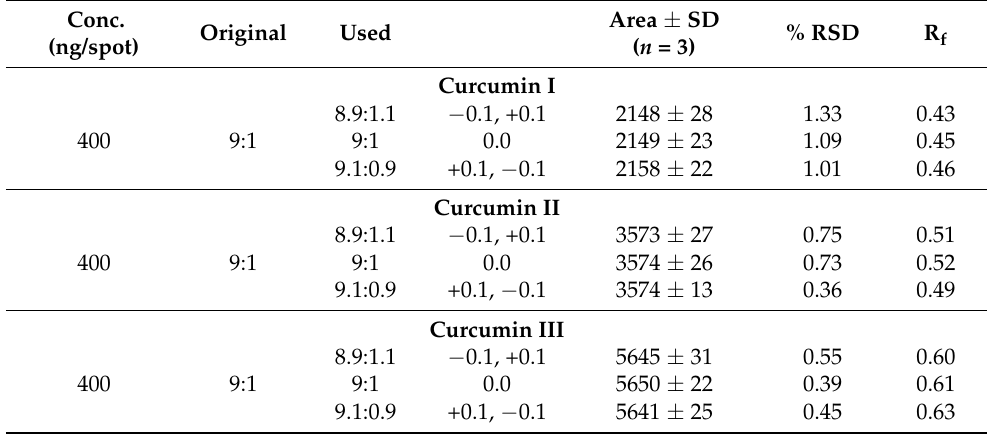
Table 4. Robustness of the proposed HPTLC method of curcumins